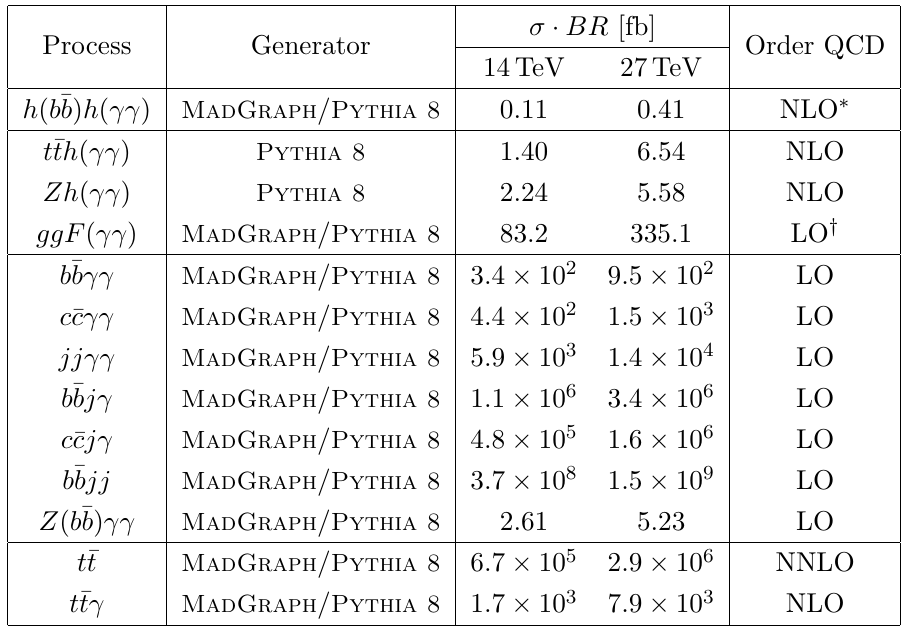
Table 3. List of signal and background processes and the event generator used to simulate their matrix elements and parton showering. Also shown are the cross sections of each process and the corresponding order in QCD at which the cross section used to normalize the expected event rate was computed. Note that we use the same naming scheme for backgrounds as ATLAS, but we do not list b (cid:22) bh as it is included in ggF as described in the text. (cid:3) The hh signal is scaled to NLO in QCD with the full m t dependence, but also includes NNLO corrections in the m t limit as well as threshold resummation e(cid:11)ects to NNLL. ! 1 y The ggF background was produced at leading order and in the m t ! 1 limit, but with two extra real emissions included. See text for